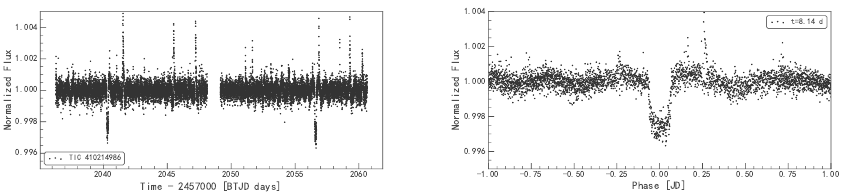
Figure 4. TESS light curve of DS Tuc A (Sector 27). ( Left ): the detrended light curve. ( Right ): the phase-folded light curve to the period of 8.14 days. TOI-837 TOI 837 is a member of open cluster IC 2602, the Southern Pleiades. It has a mass of ∼ 1.1 M (cid:12) and radius of ∼ 1 R (cid:12) . It was observed by TESS in Sector 10 and 11. The raw light curve shows a modulation with an semi-amplitude of ∼ 1% and period of ∼ 3 day. The detrended and phase folded light curves are shown in Figure 5. From the TESS ligexamining thht curve, the star is in a relatively quiet phase during the TESS observation, which makes it relatively easier to search for smaller planets. Bouma et al. [2] detected one planet slightly smaller than Jupiter in this system, with a period of 8.325 days.